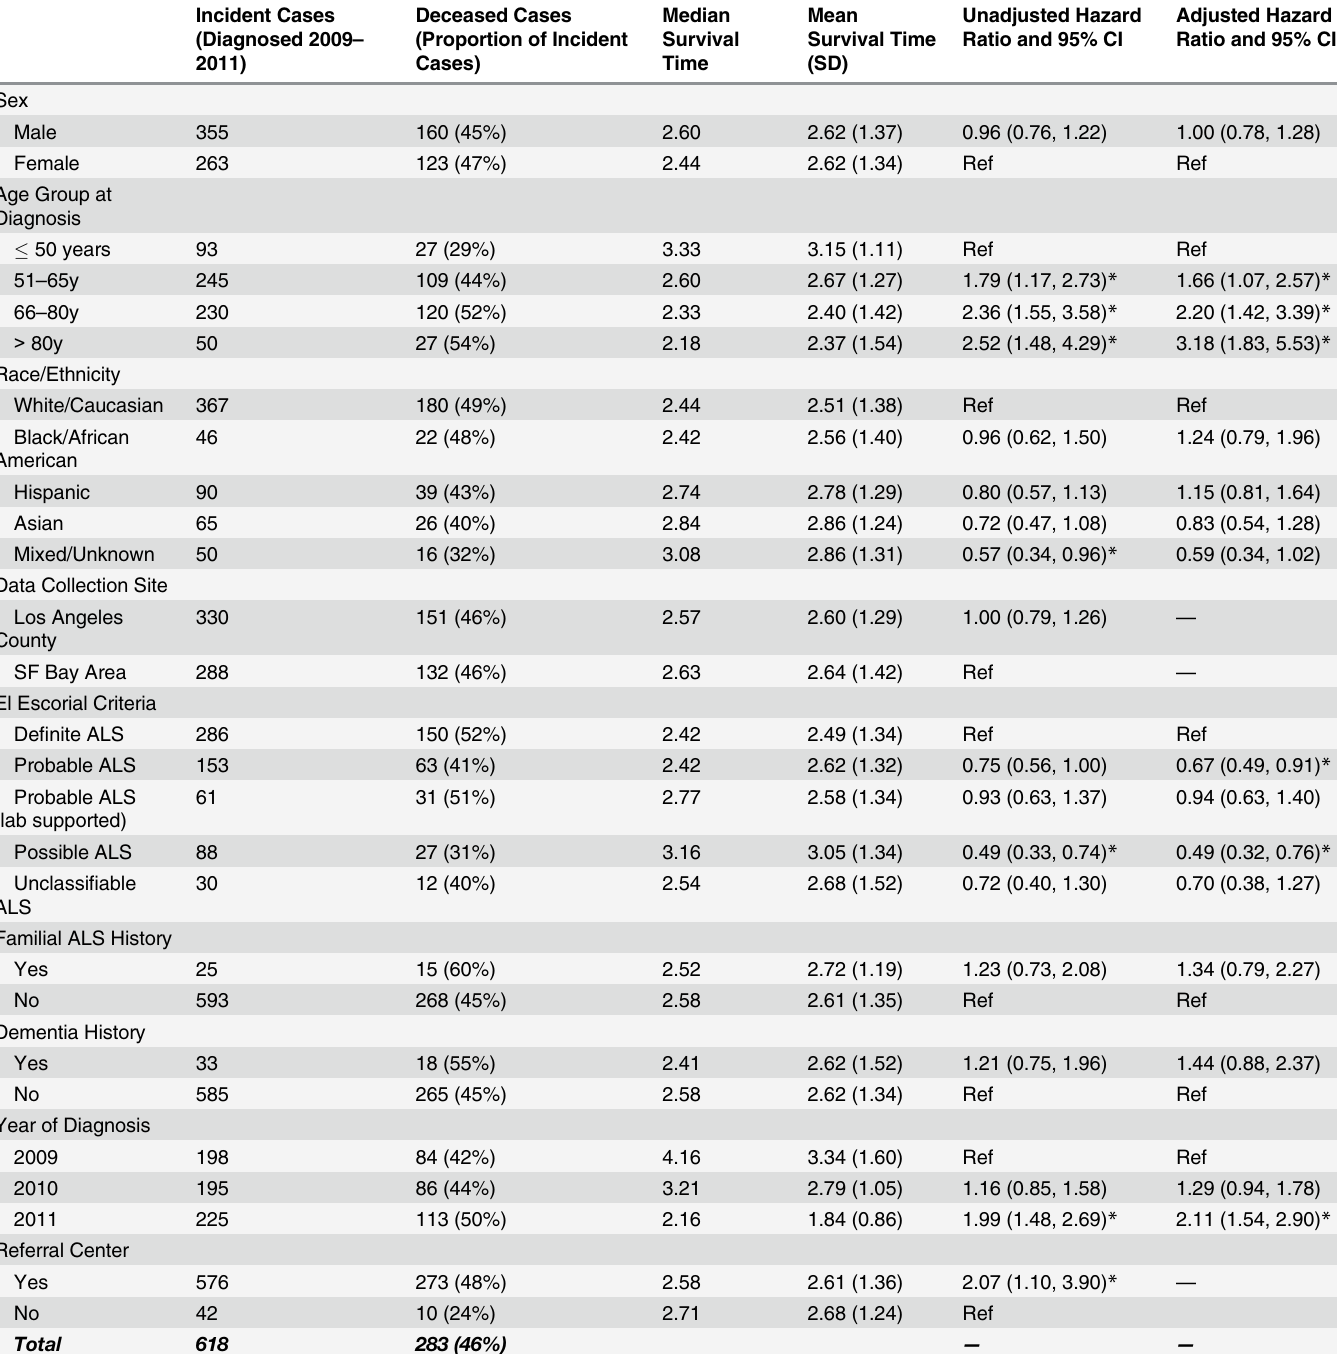
Table 2. Characteristics (Proportion among Incident Cases) and Survival in Years of ALS Cases Residing in Los Angeles and Selected San Fran- cisco Bay Area Counties (Diagnosed 2009 – 2011, Deceased 2009 –